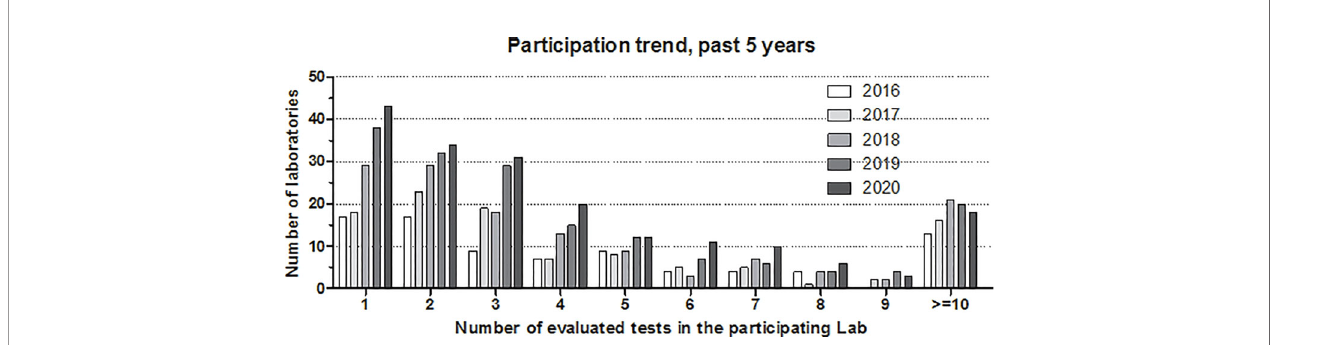
FIGURE 2 | Number of participating laboratories in the external quality assurance program of diagnostic complement laboratories. Participation trends in the past 5 years (2016 – 2020) are shown separately by the number of tests evaluated in the given laboratory. Note: laboratories participating with more than nine tests are merged as “ ≥ 10. ”